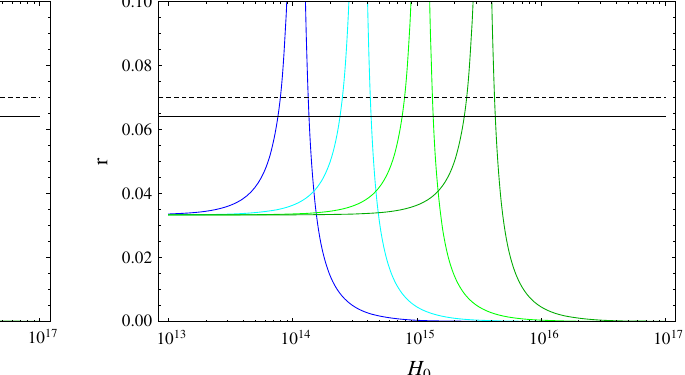
of H 1 and H 0 , respectively. The horizontal dashed black line sets the limit r < 0 . 07, while the horizontal black line the limits r < 0 . 064, according to Planck 2015 and Planck 2018 results,